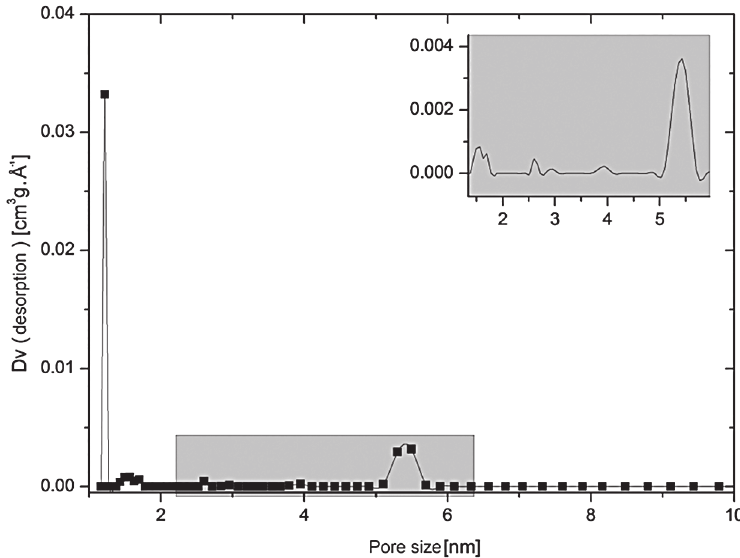
Figure 4 - Pore distribution of AVF sample based on adsorption/desorption isotherm using NLDFT/Monte Carlo